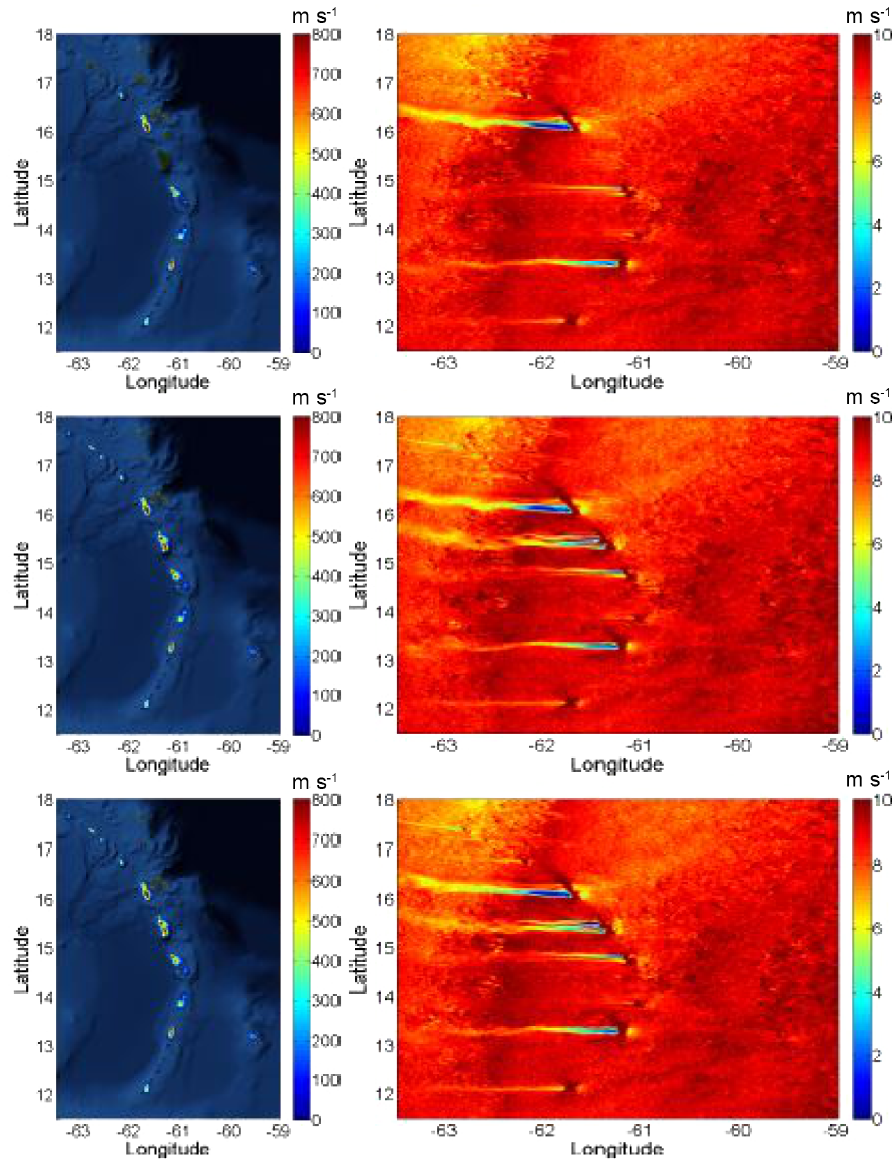
Figure 5. The WRF model’s GTOPO30-based terrain height (upper left), SRTM30-based terrain height (middle left), and GMTED30-based terrain height (lower left). Upper right, middle right, and lower right panels depict averaged wind speed in the boundary layer from 06:00 to 12:00UTC on 1 August 2013 as simulated by the GTOPO30-based, SRTM30-based, and GMTED30-based runs,